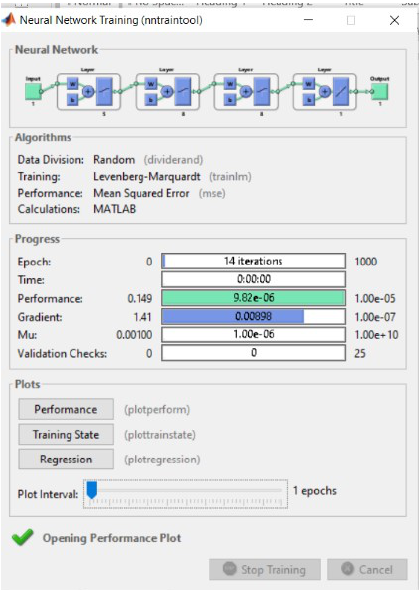
Figure 5. Structure of the constructed